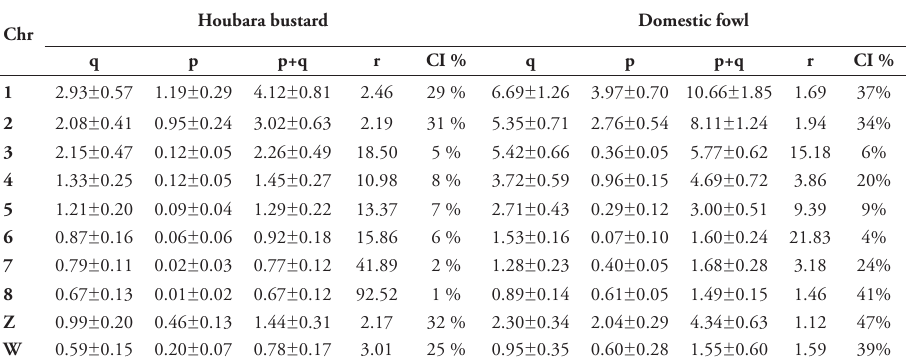
Table 2. Measurements of eight macrochromosomes and sex chromosomes ZW of Houbara bustard Chlamydotis undulata undulata and Domestic fowl Gallus domesticus . Chr : chromosome, q : long arm, p : short arm, p+q : total length, r : arm ratio q/p , CI % : centromeric index= p/p+q × 100 . Lengths are given in micrometer (μm) ± standard deviation. Houbara bustard Domestic Chr